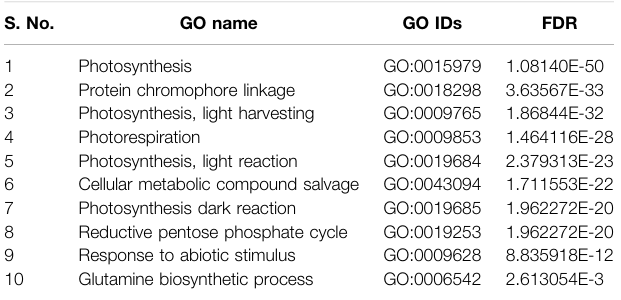
TABLE 5 | List of top 10 biological processes with GO IDs that are overrepresented in downregulated DEGs in root tissues of PBW677. S.